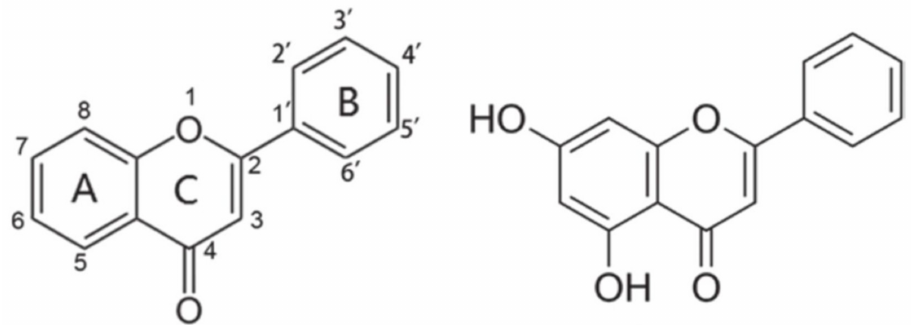
Figure 1. Basic structure of flavones showing fused A and C rings, and phenyl B rings with corre- sponding numbering system ( left figure ). Structure of the flavonoid chrysin, 5,7-dihydroxyflavone ( right figure ).